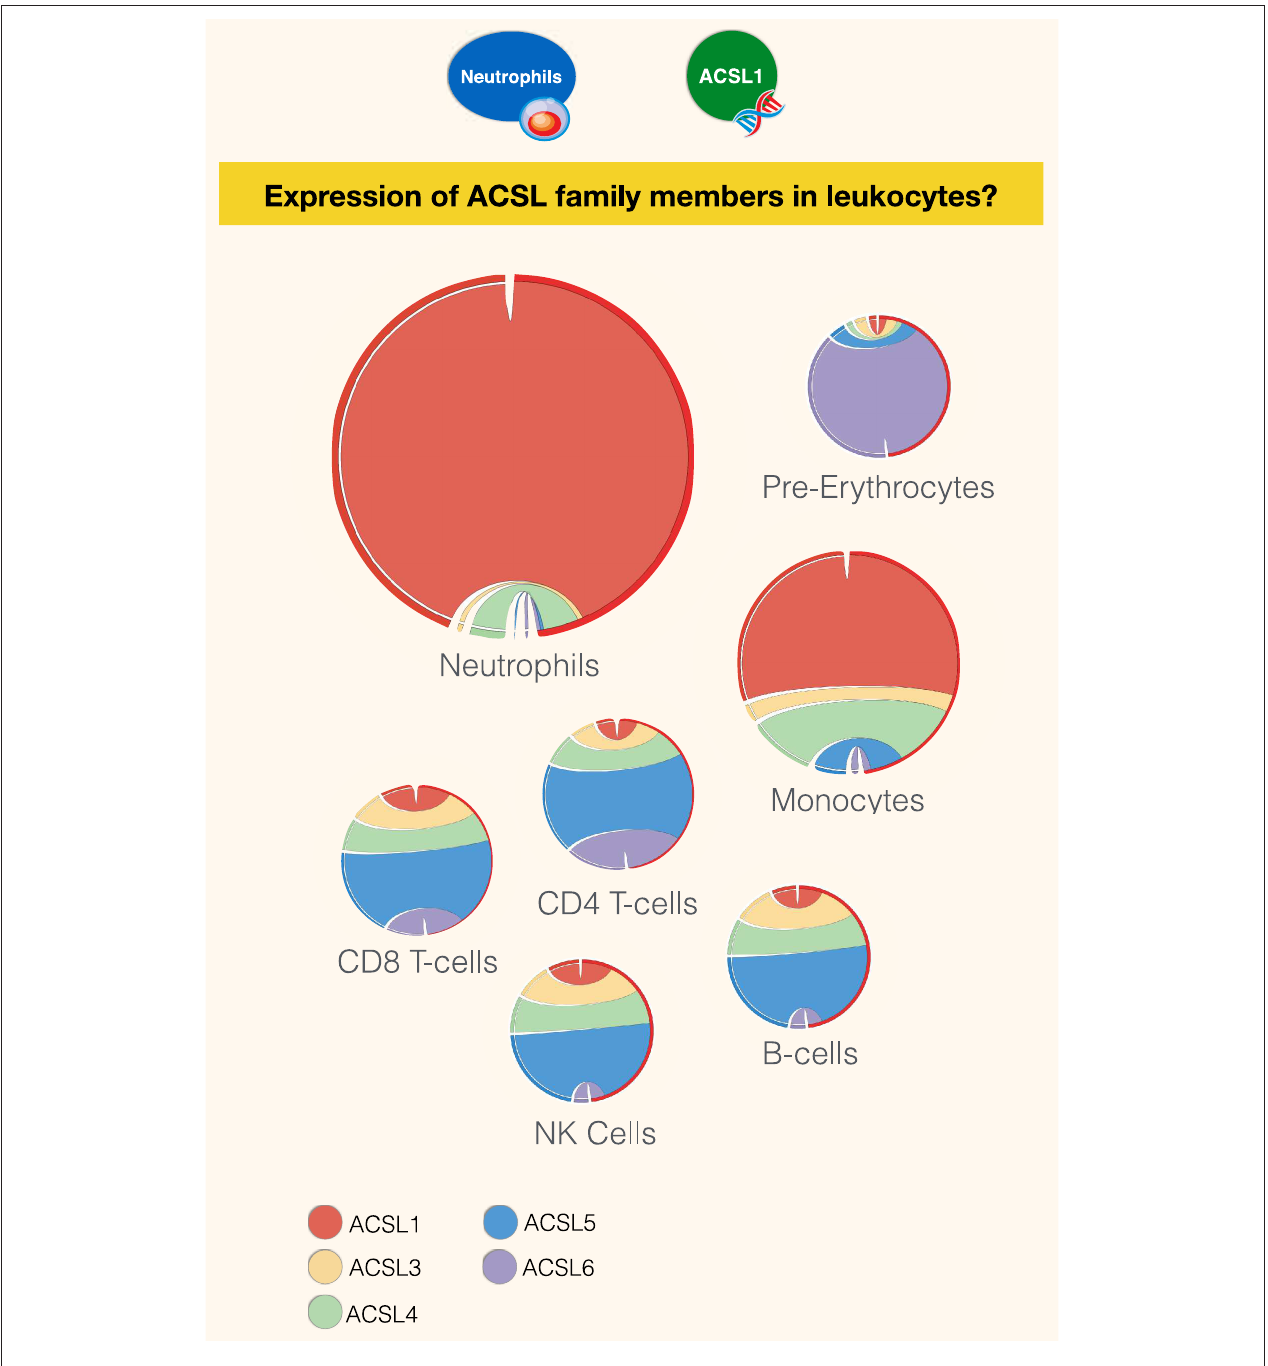
FIGURE 3 | Restriction of expression of ACSL family members transcripts in human leukocyte populations. Relative transcript abundance levels for the 5 members of the ACSL family are represented with cord plots for 7 different blood leukocyte populations. Expression data used to generate the plots were obtained from public domain RNAseq dataset with accession ID GSE60424 (93), with the exception pre-erythrocytes expression data, which was obtained from the BioGPS dataset (21). Each family member is represented by a different color: ACSL1 (red), ACSL2 (beige), ACSL4 (green), ACSL5 (blue), and ACSL6 (purple). The size of the circle is proportional to relative expression levels of ACSLs. For instance, expression in neutrophils was about four times higher than in monocytes and ten times higher than in other cell populations.